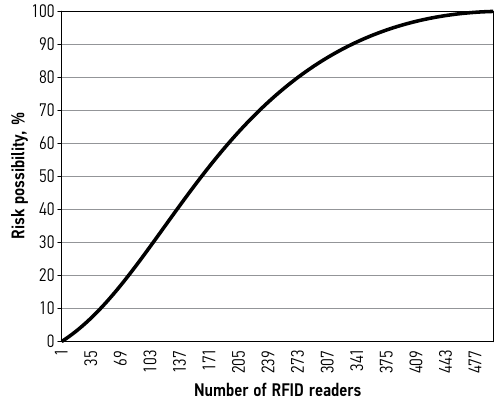
Fig. 4. The dependency of risk possibility on the number of measurements (check points over the whole